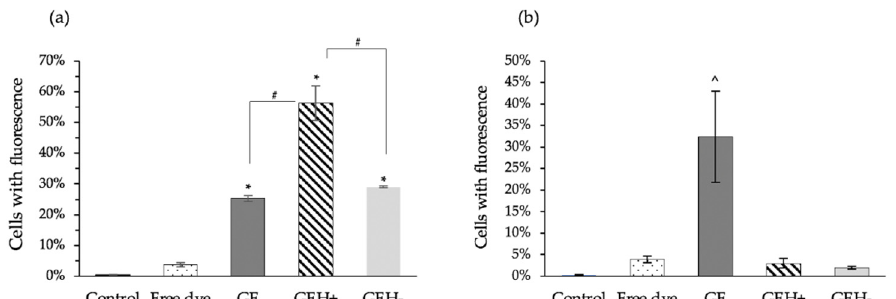
Figure 5. Fluorescent cells percentage examined by flow cytometry: ( a ) 1 h incubation with variant formula, and ( b ) pretreated with HA, then cocultured with dye containing NPs. (mean ± SD, n = 3) (* p < 0.05 compared with free dye, # p < 0.05 compared with GEH+, ^ p < 0.05 compared with all groups).